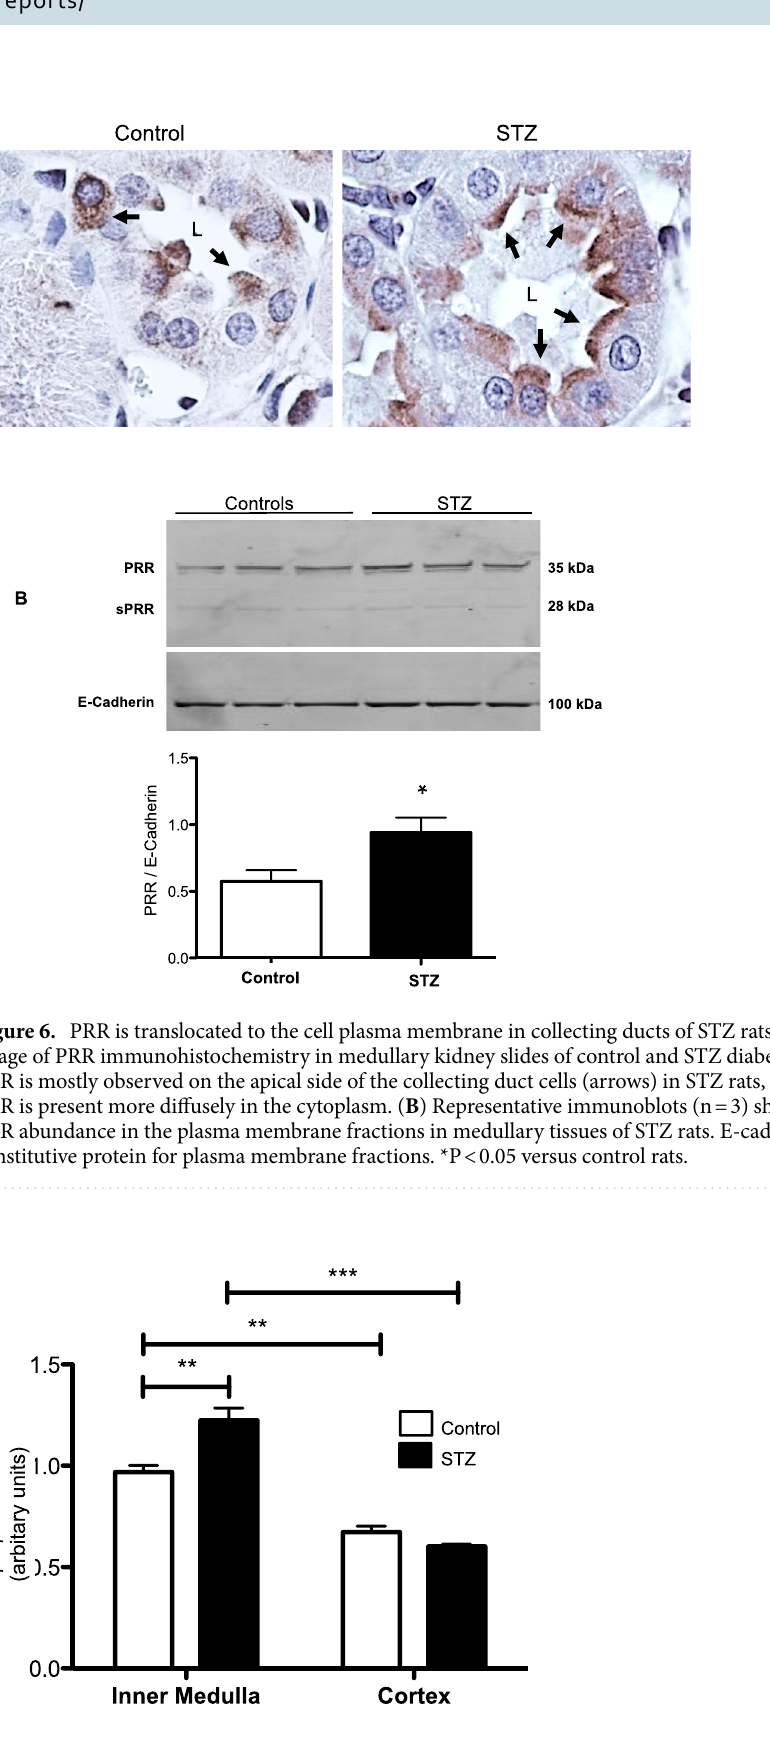
Figure 7. Quantitative RT-PCR in medulla and cortex of control and STZ rats showed the induction of TGF-β in the renal medulla but not in cortical tissues (n = 4). *P < 0.05, **P <